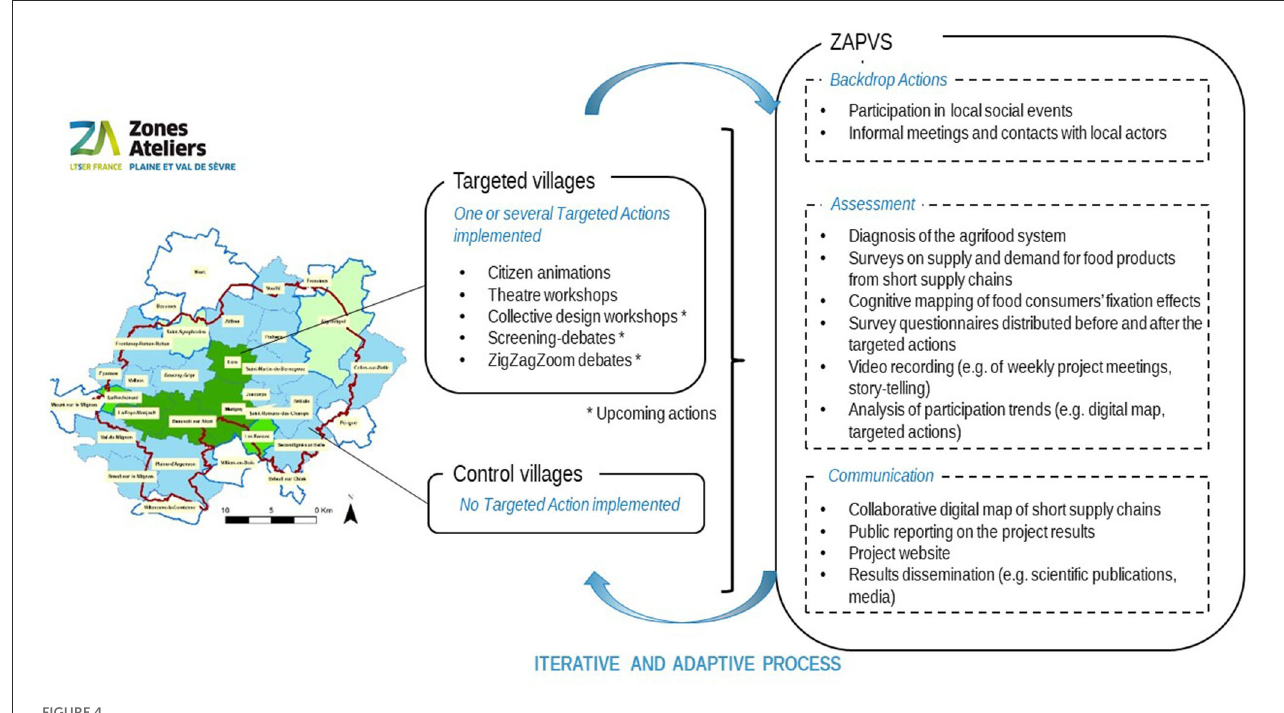
FIGURE4 The different actions implemented in the Aliment’Actions